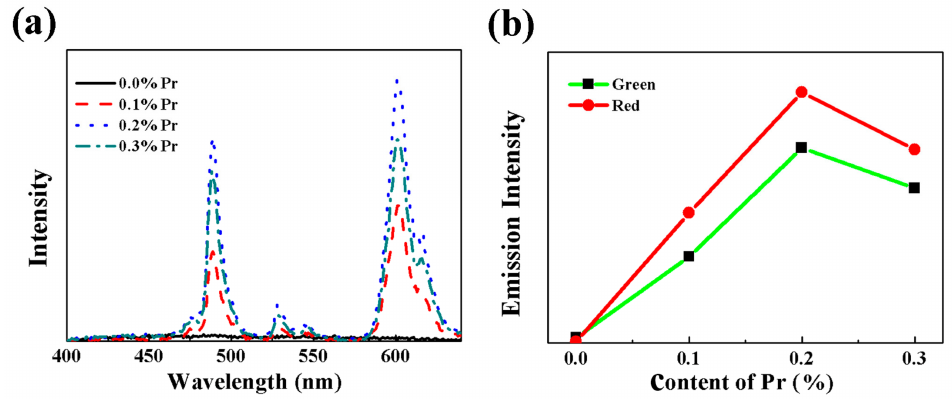
Figure 4. ( a ) Photoluminescence (PL) spectra of the BZT-0.5BCT- x Pr 6 O 11 ceramics under 362 nm excitation; ( b ) Plotted curve of the green and red emission intensities for different x under 362 nm excitation.